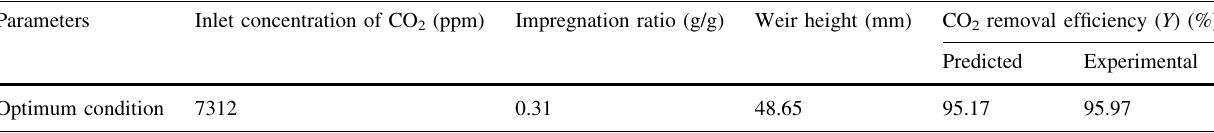
Table 6 Optimal processing conditions from numerical optimization